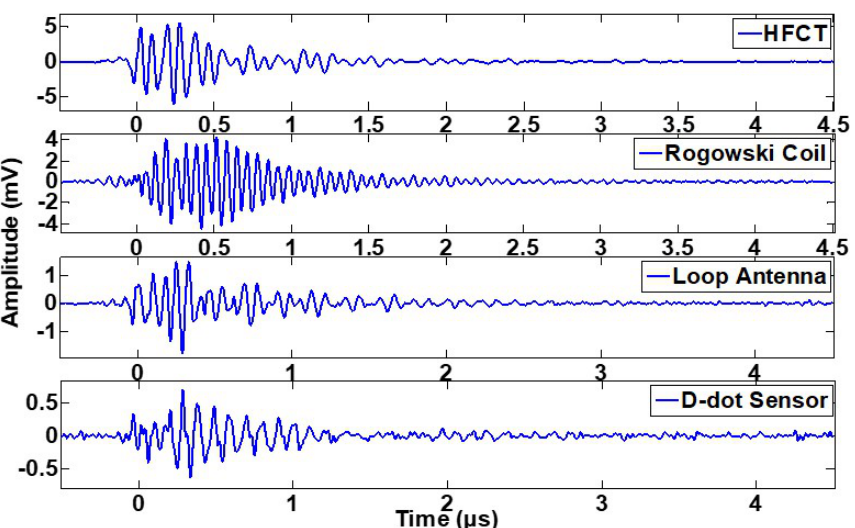
Figure 15. Surface PD over the insulator.